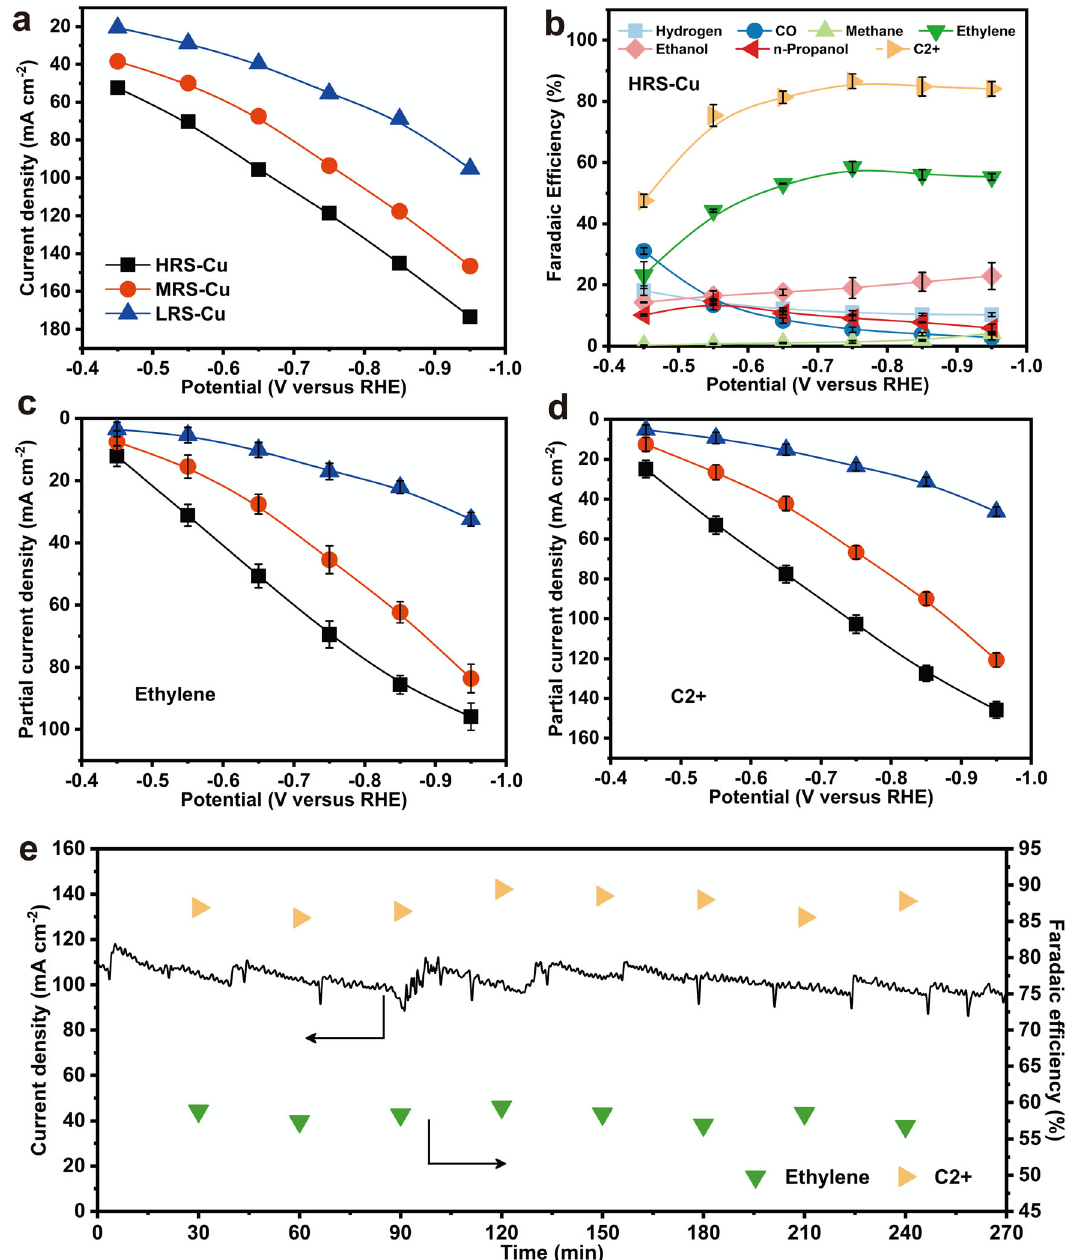
Fig. 2 Catalytic performance of various Cu fi lms. a Current − voltage (I – V) curves on various electrodes measured in CO 2 - fl owed 2 M KOH electrolytes. b Faradaic ef fi ciencies of CO 2 reduction products on the HRS-Cu sample as a function of different applied potentials. c Ethylene and d C2 + products partial current densities obtained on various samples at different applied potentials. e Stability test over a span of 4.5 h (270 min) of CO 2 − electrolysis in 2 M KOH (aq.) at − 0.75 V versus the RHE. The oscillation of the current density is due to the repeated release of O 2 bubbles in the anode side of the fl ow cell. C2 + products include ethylene, ethanol, and n-propanol. Error bars represent the standard deviation from at least three independent